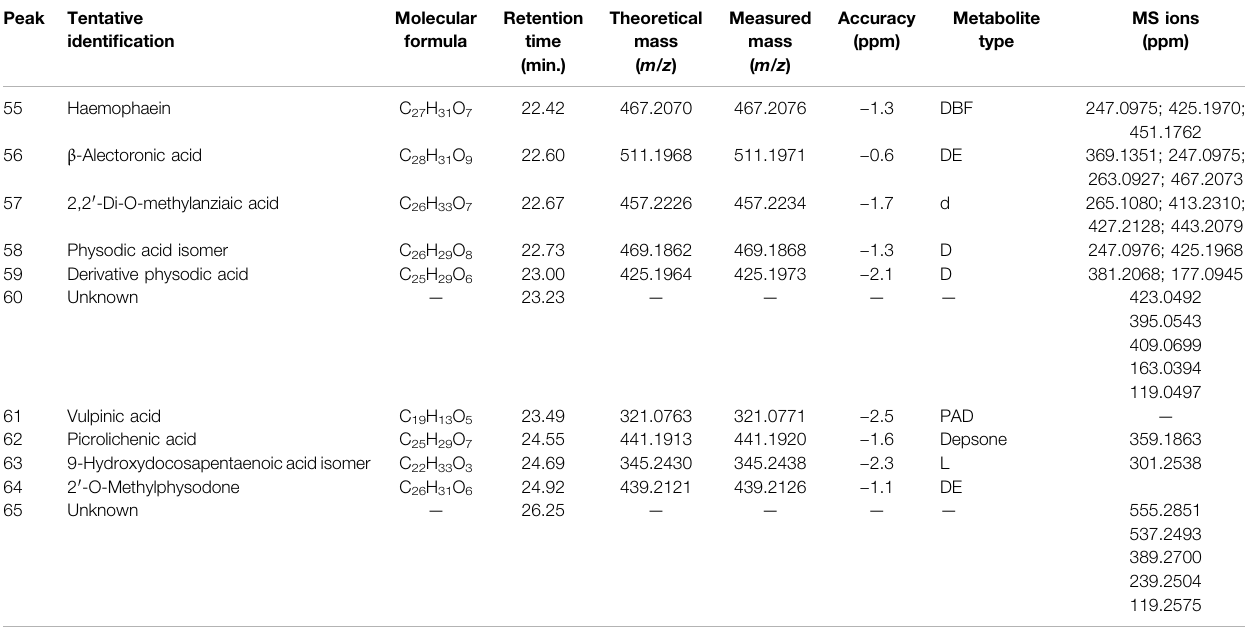
Frontiers in Pharmacology |